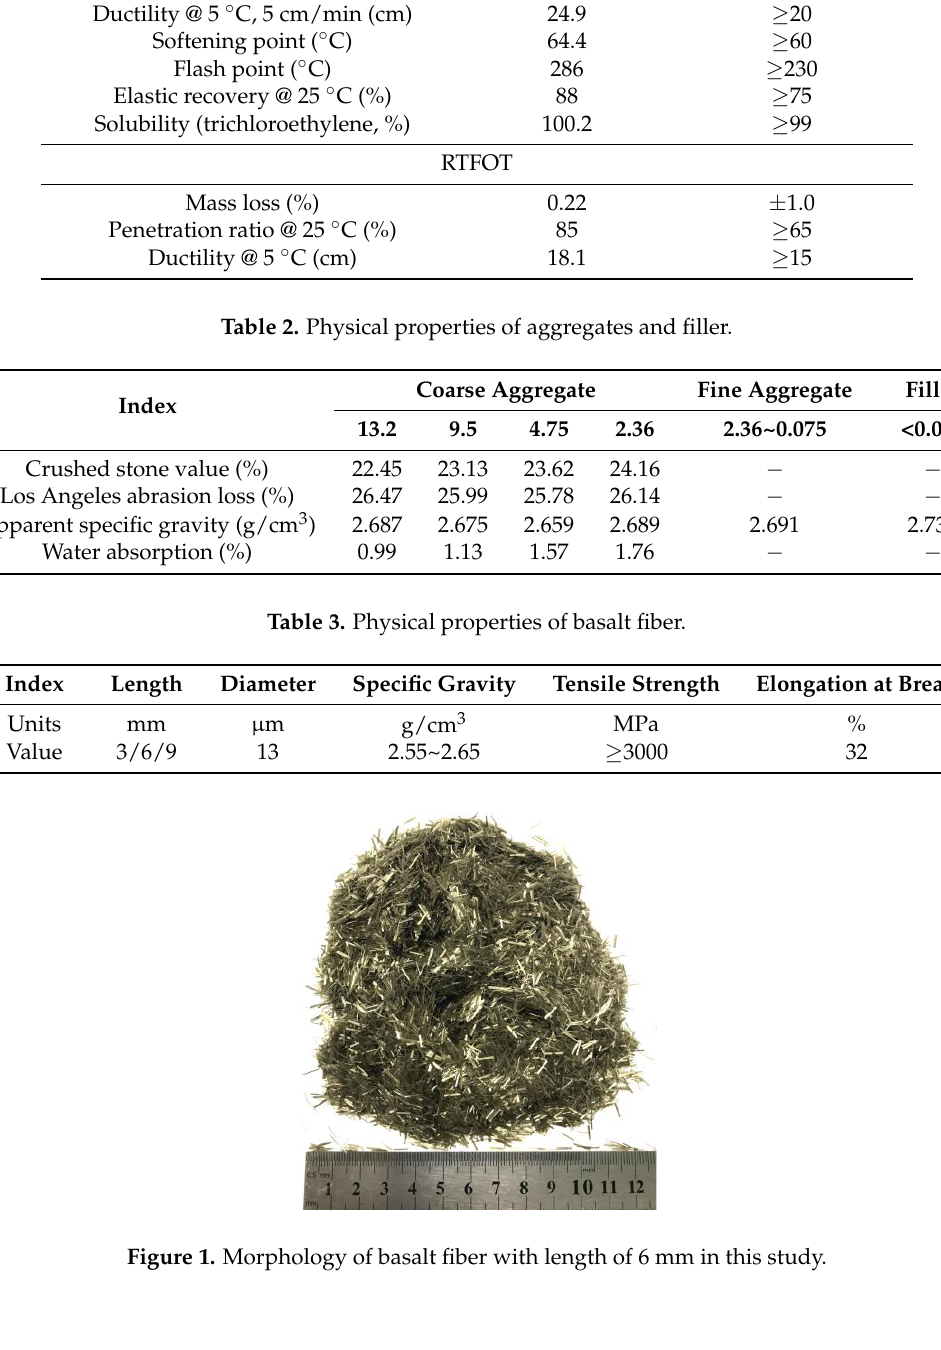
Table 1. Basic physical properties of SBS-modified asphalt.